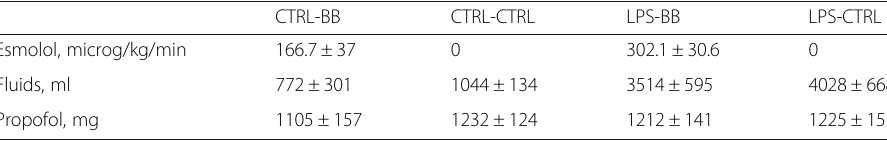
CTRL-BB CTRL-CTRL LPS-BB LPS-CTRL Esmolol, microg/kg/min 166.7 ± 37 0 302.1 ± 30.6 0 Fluids, ml 772 ± 301 Propofol,